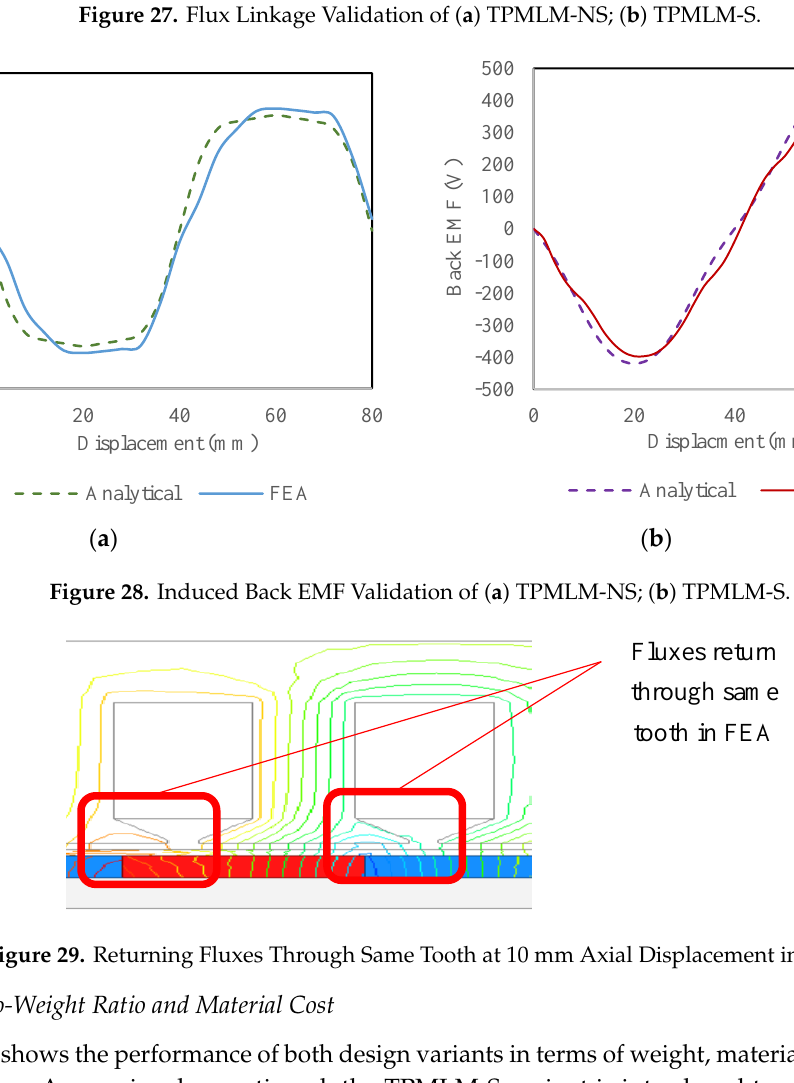
Figure 27. Flux Linkage Validation of ( a ) TPMLM-NS; ( b ) TPMLM-S.